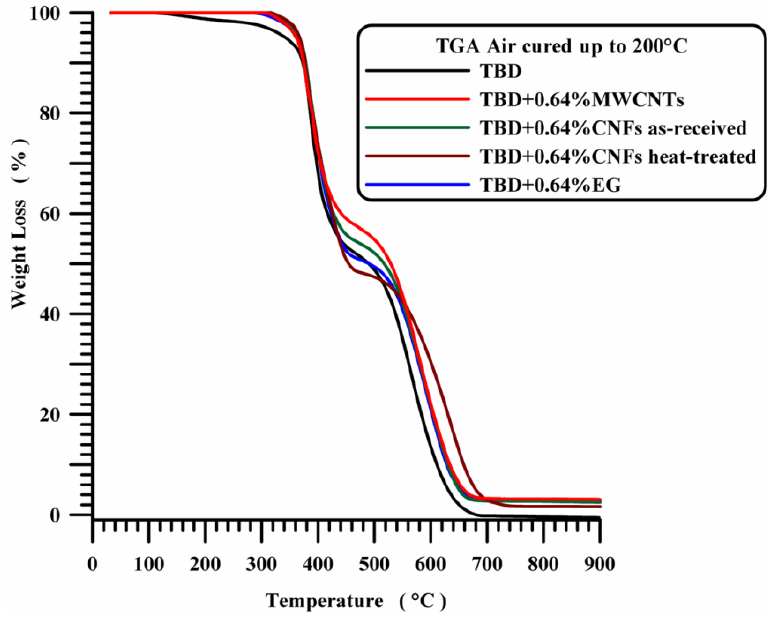
Figure 10. TGA curves in air of neat and nanocomposite systems.